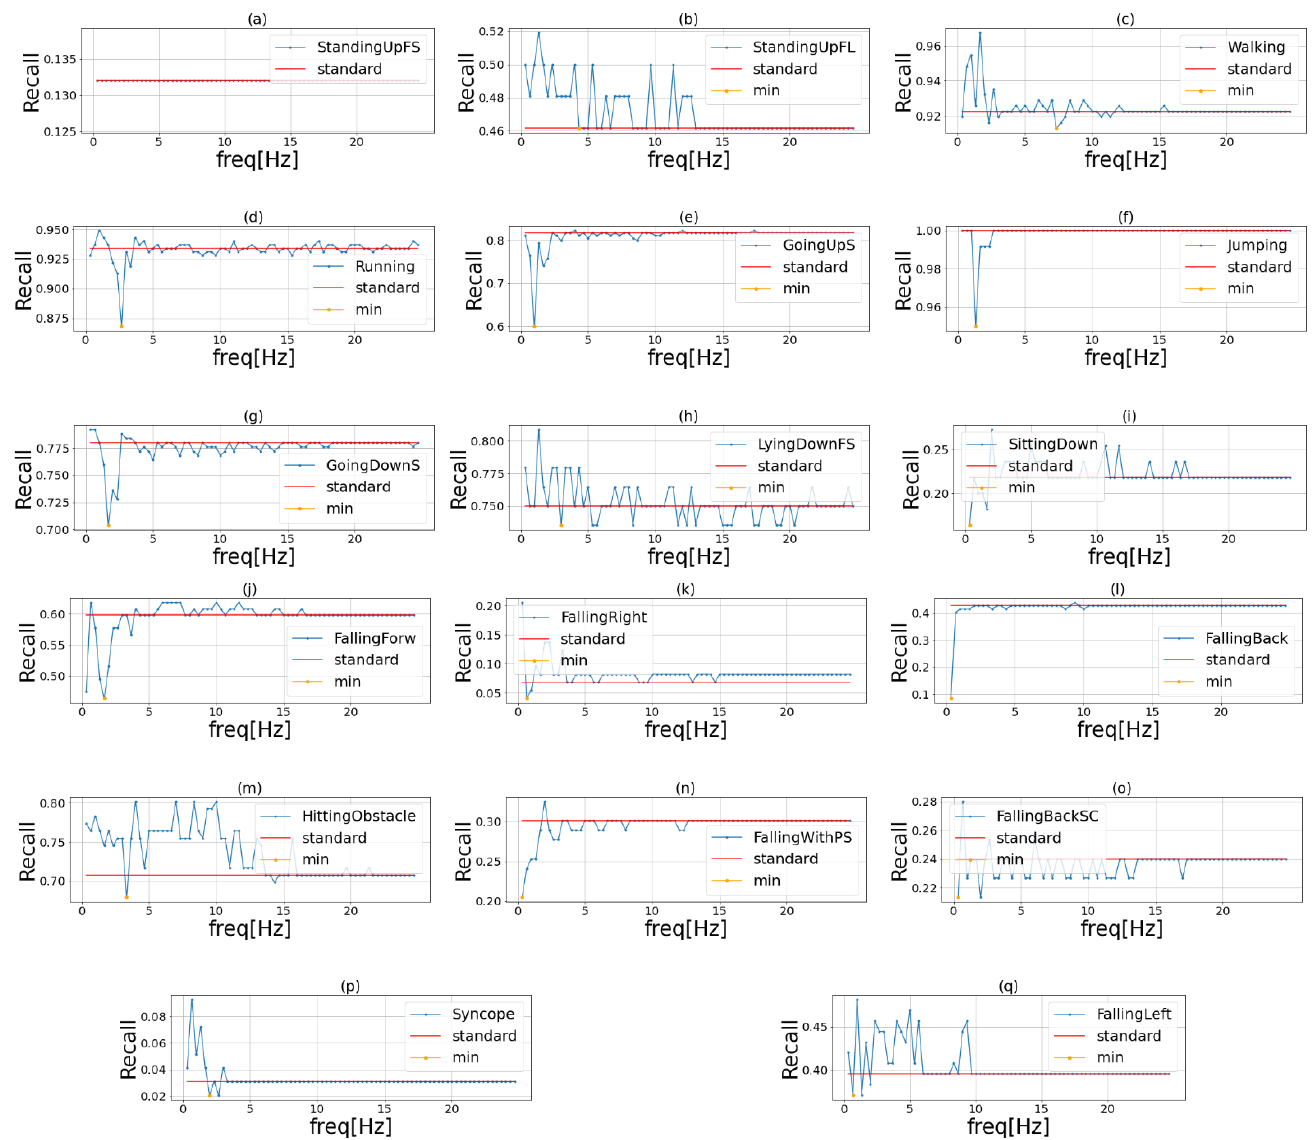
Figure 4. Important frequency of each activity in UniMiB. The blue line in the graph shows the recognition accuracy when we masked the frequencies of the original sensor data in order. The red line shows the recognition accuracy when we used the original data. The yellow point is the lowest recognition accuracy when we use the frequency masked data. Each activity is ( a ) StandingUpFS, ( b ) StandingUpFL, ( c ) Walking, ( d ) Running, ( e ) GoingUpS, ( f ) Jumping, ( g ) GoingDownS, ( h ) LyingDownFS, ( i ) SittingDown, ( j ) FallingForw, ( k ) FallingRight, ( l ) FallingBack, ( m ) HittingObstacle, ( n ) FallingWithPS, ( o ) FallingBackSC, ( p ) Syncope, ( q ) FallingLeft. Table 4. Accuracy of the three models using each dataset. Bold type indicates the highest accuracy using the respective